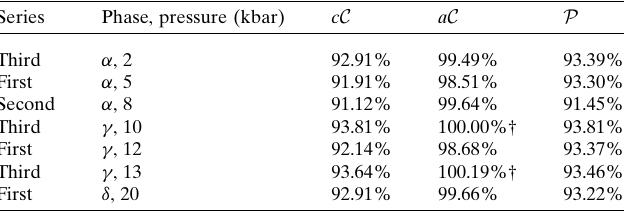
Table 2 Classical completeness, applicable completeness and potency of the data collected to 0.6 A˚ (cid:3) 1 in the HP experiments performed.